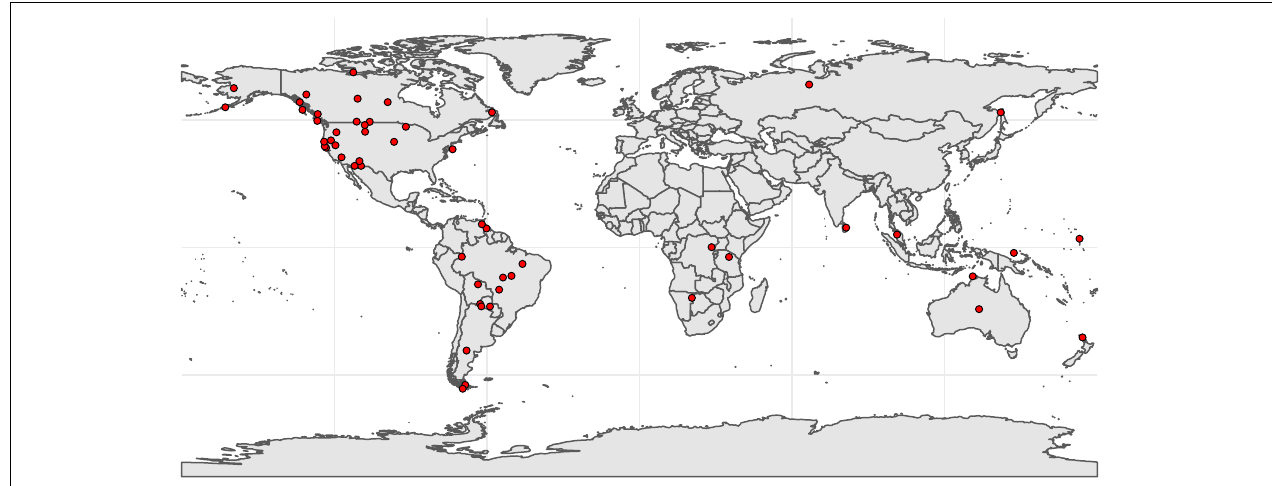
FIGURE 1 | Map showing the location of the 54 societies for which data on children’s tools and toys were available. Note that 52% of societies and 60% of objects were from North America from Riede et al. (forthcoming). TABLE 1 | Categories of objects, their definitions, and examples. Adapted from Riede et al. (forthcoming). Category Definition